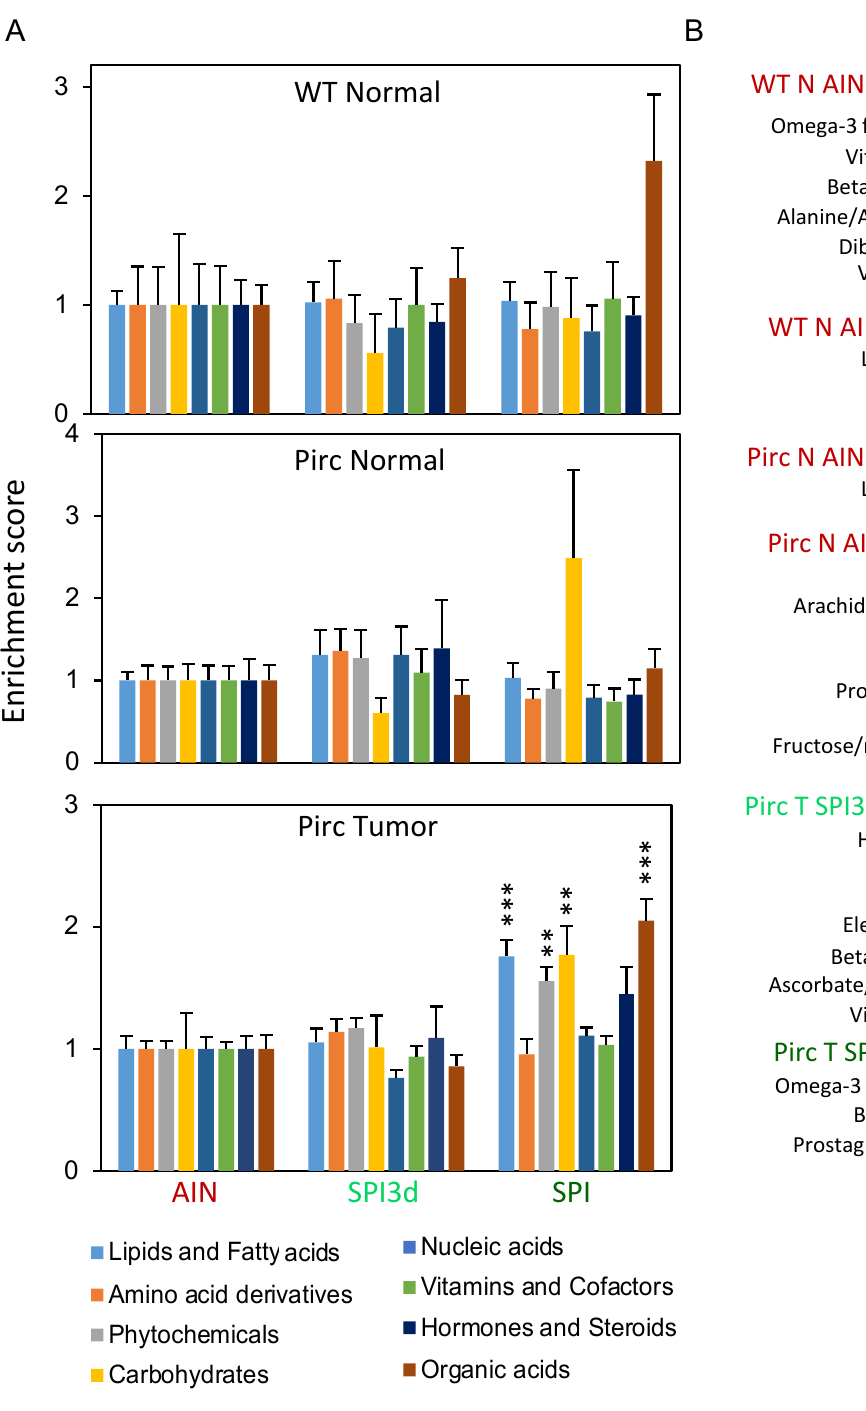
Figure 2. Compound categories prioritized from metabolomic analyses in Pirc and WT rats. ( A ) Mum- michog coupled to KEGG Compound library identified eight categories of small molecules. Data are shown as mean ± SD. One–way ANOVA was used to compare the mean of each column with the mean of every other column in the dataset, with Tukey correction for multiple comparisons (GraphPad Prism 9.0); ** p < 0.01; *** p < 0.001. ( B ) Enriched metabolic pathways for the group comparisons indicated; mummichog cutoff at 0.2, p < 0.05 significance level. N, normal; T,